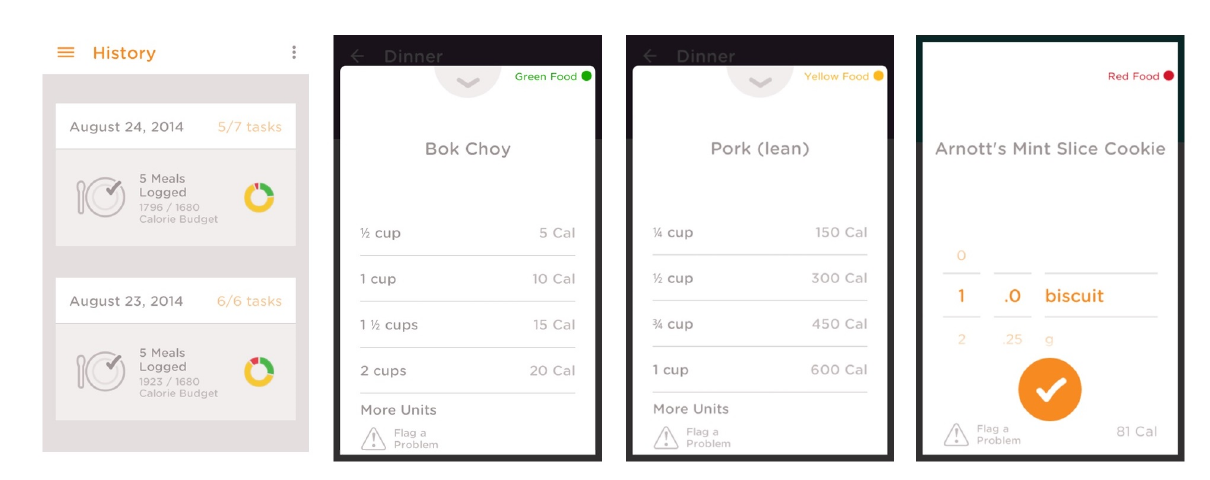
Figure 3. Screenshot of sample smartphone app which provides estimates of energy requirements and searchable food databases (from Noom Weight Loss Coach by Noom, Inc).